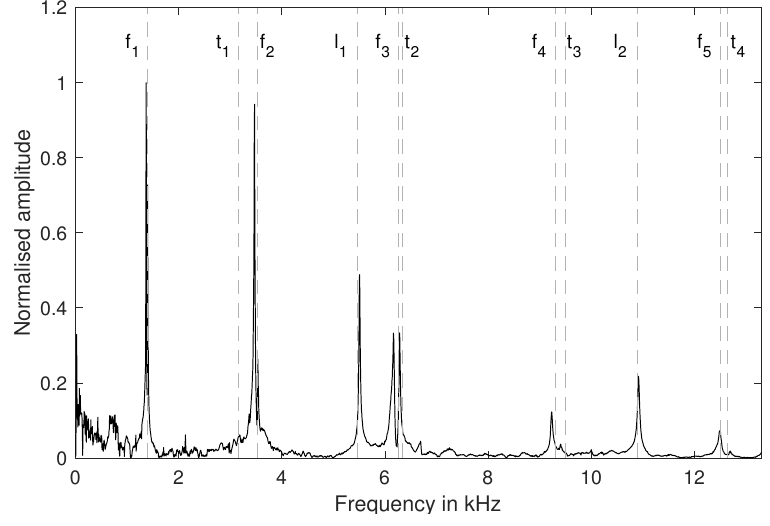
Figure 7. Spectral analysis of the impulse excitation data. The doted lines mark natural frequencies based on FEM calculations. The Young’s and shear modulus of the FEM material model result from a error minimisation between the peaks in the spectrum and the calculated eigenfrequencies ( < 12kHz). Table 2. Results for elastic parameters of inorganically-bound core materials. The evaluation of the acoustical data was performed with an error minimisation for the Young’s modulus and the shear